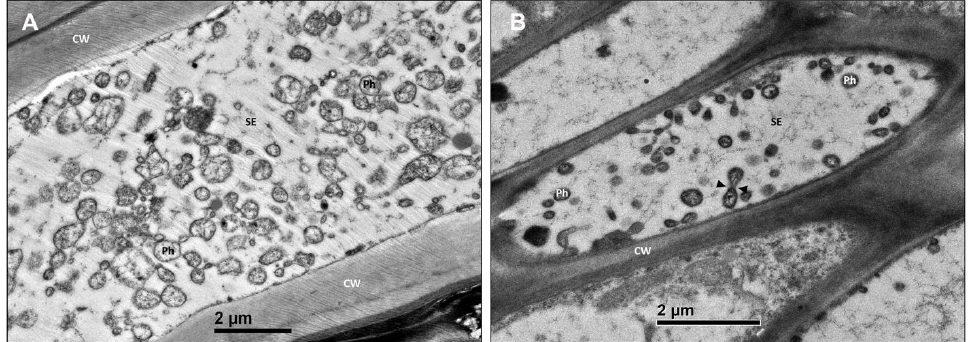
Figure 3. Transmission electron microscope examination of symptomatic samples. Micrographs of phytoplasma bodies within leaf veins of the symptomatic green pea ( A ) and parthenium weed ( B ). Black arrowheads indicate phytoplasma undergoing cell division. The sieve elements were occupied by pleomorphic phytoplasma bodies. CW, cell wall; Ph, phytoplasma; SE, sieve